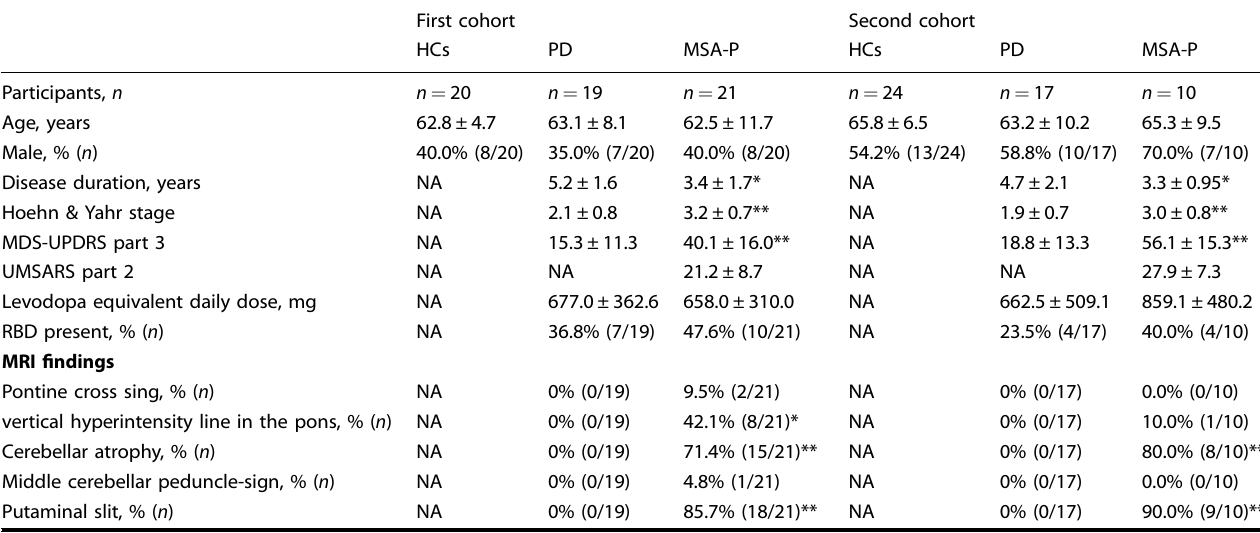
Table 1. Demographics, clinical features, and MRI fi ndings in the various subject